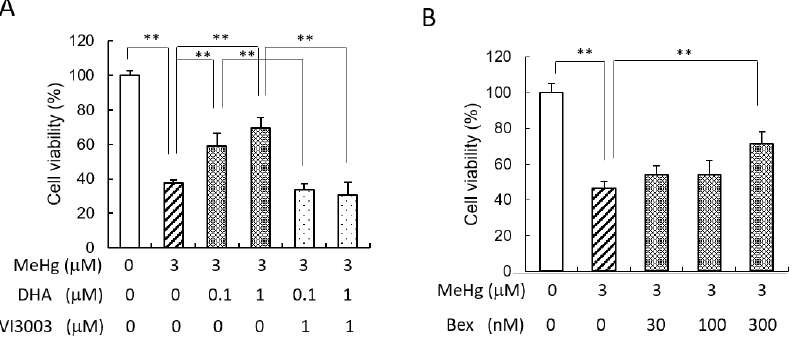
Figure 2. The protective effect of DHA was suppressed by an RXR antagonist. ( A ) SH-SY5Y cells